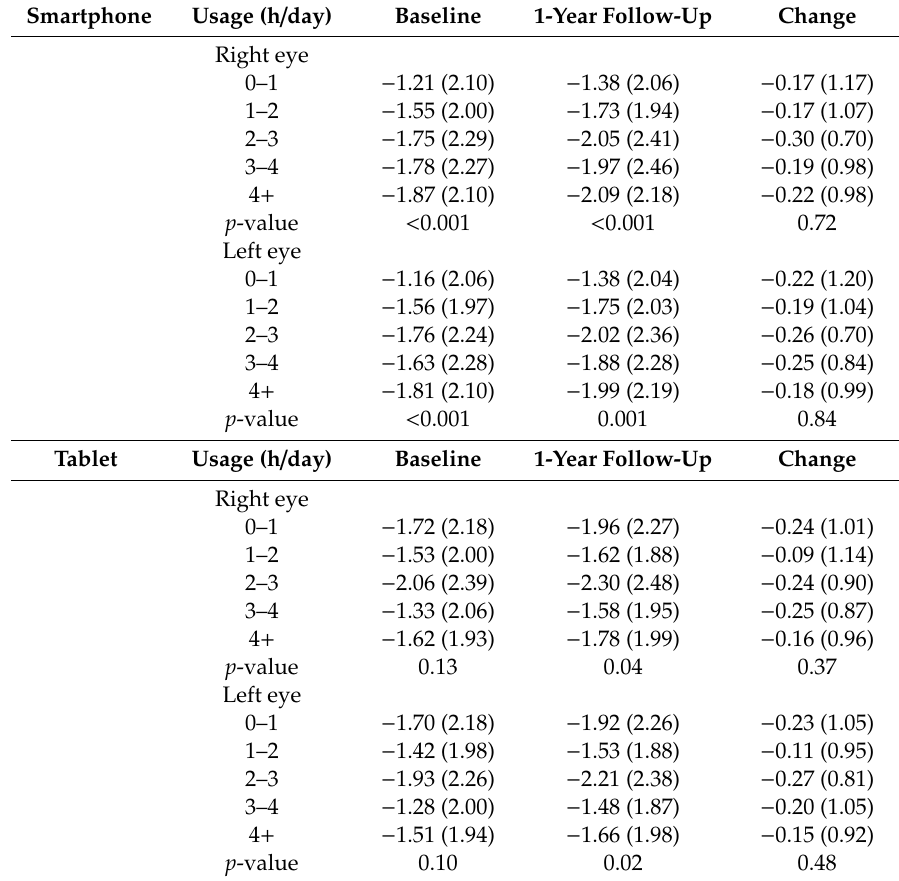
Table 2. Univariate association between smartphone and tablet usage (hours per day) on spherical equivalent refraction (SER, D).